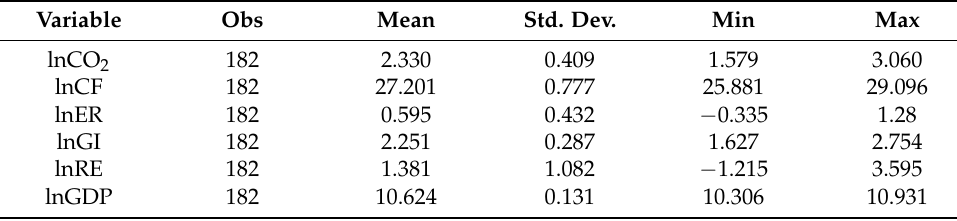
Table 2. Descriptive statistics.